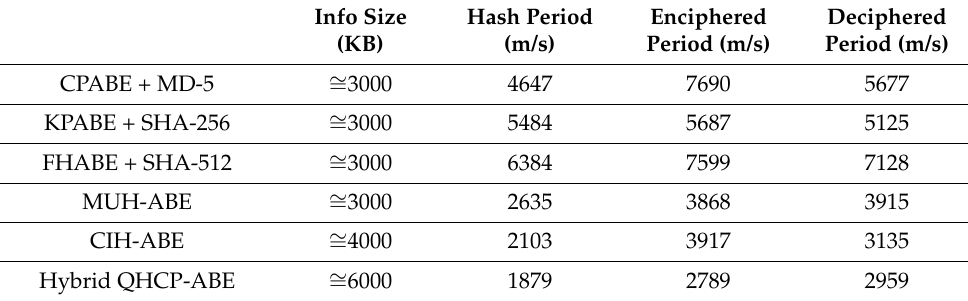
Table 2. Memory occupancy efficacy of proposed standard Vs. conventional ABE standards.